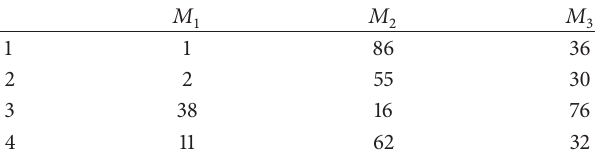
Table 9: Data of 4-job-3-machine instance of Example